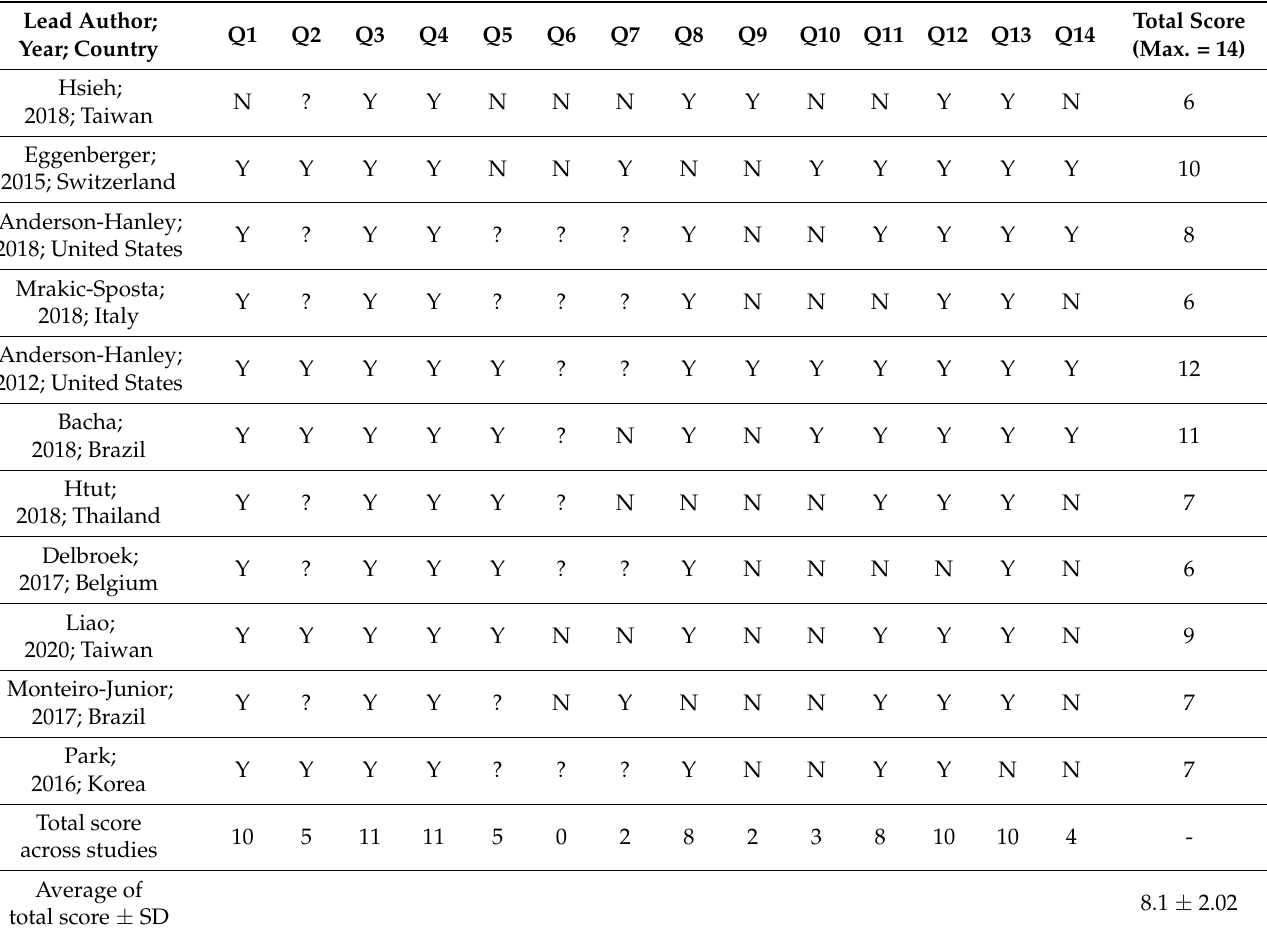
Table 2. Quality assessment scores of included studies using modified Delphi list.